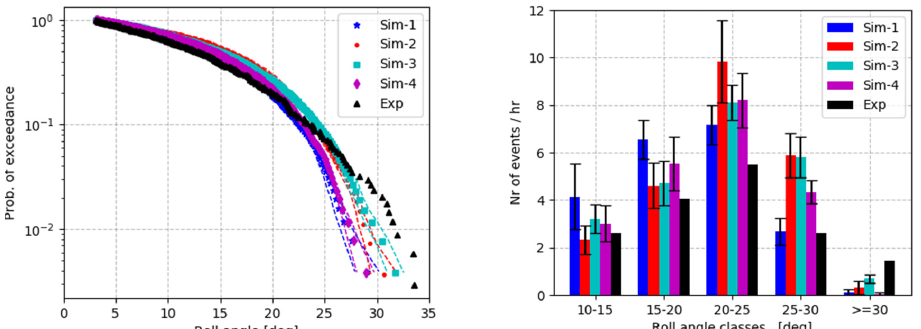
Figure 11. Statistics of extreme values of the roll motions (left) and the number of parametric roll events / hour subdivided in classes (right). Results of 4 sets of simulations, each the total of 10 simulations of 3 h duration, compared to results of experiments (duration 3 h). The mean (markers) and the 95% confidence interval (dashed lines) obtained from 10 realizations of the wave are shown for the simulations (left). The mean (bars) and the 95% confidence intervals (error bars) obtained from 10 realizations are plotted on the right. Sea state: Following seas, Hs = 4 m, Tp = 13.5 s, speed vs. = 7.9 kn.